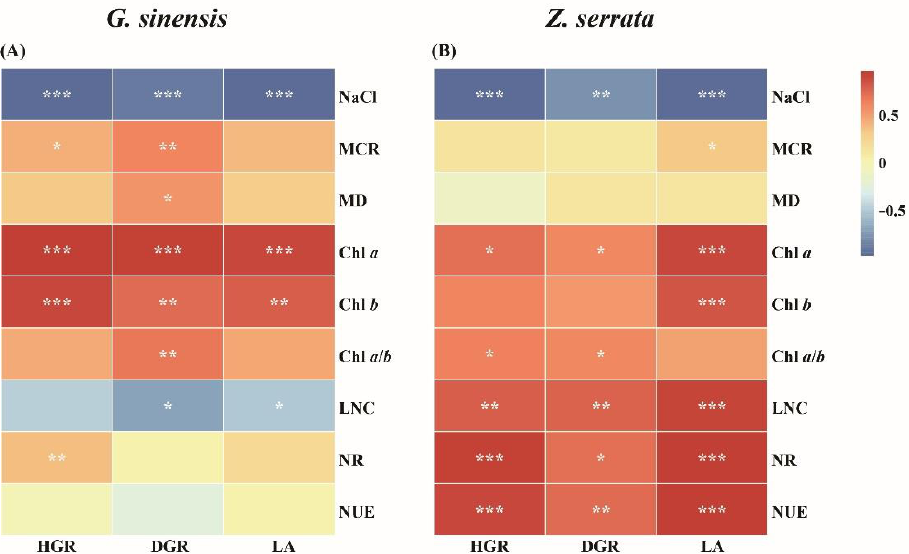
Figure 6. Correlation analysis of the NaCl level, mycorrhizal colonization rate, mycorrhizal dependency, leaf area, leaf physiology, and plant growth. ( A ) Correlation analysis of various indicators of G. sinensis ; ( B ) Correlation analysis of various indicators of Z. serrata . Abbreviations: NaCl, NaCl level; MCR, mycorrhizal colonization rate; MD, mycorrhizal dependency; Chl a , chlorophyll a content; Chl b , chlorophyll b content; Chl a / b , ratio of chlorophyll a content to chlorophyll b content; LNC, leaf N content; NR, nitrate reductase activity; NUE, photosynthetic N-use efficiency. *** Indicates significant correlation at p < 0.001; ** indicates significant correlation at p < 0.01; * indicates significant correlation at p < 0.05. The darker the color, the stronger the correlation; the lighter the color, the weaker the correlation.